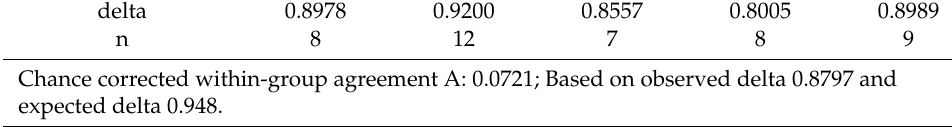
Table 6. Pair comparison of macroinvertebrate assemblages of the five rivers based on Tukey’s post-hoc test. Pairs F Model R 2 p -Value Adjusted p SO-EA 1.640 0.084 0.037 0.37 SO-SA 2.144 0.142 0.002 0.02 * SO-JU 2.999 SO-YA 1.801 0.107 0.09 EA-SA 2.264 0.118 0.002 0.02